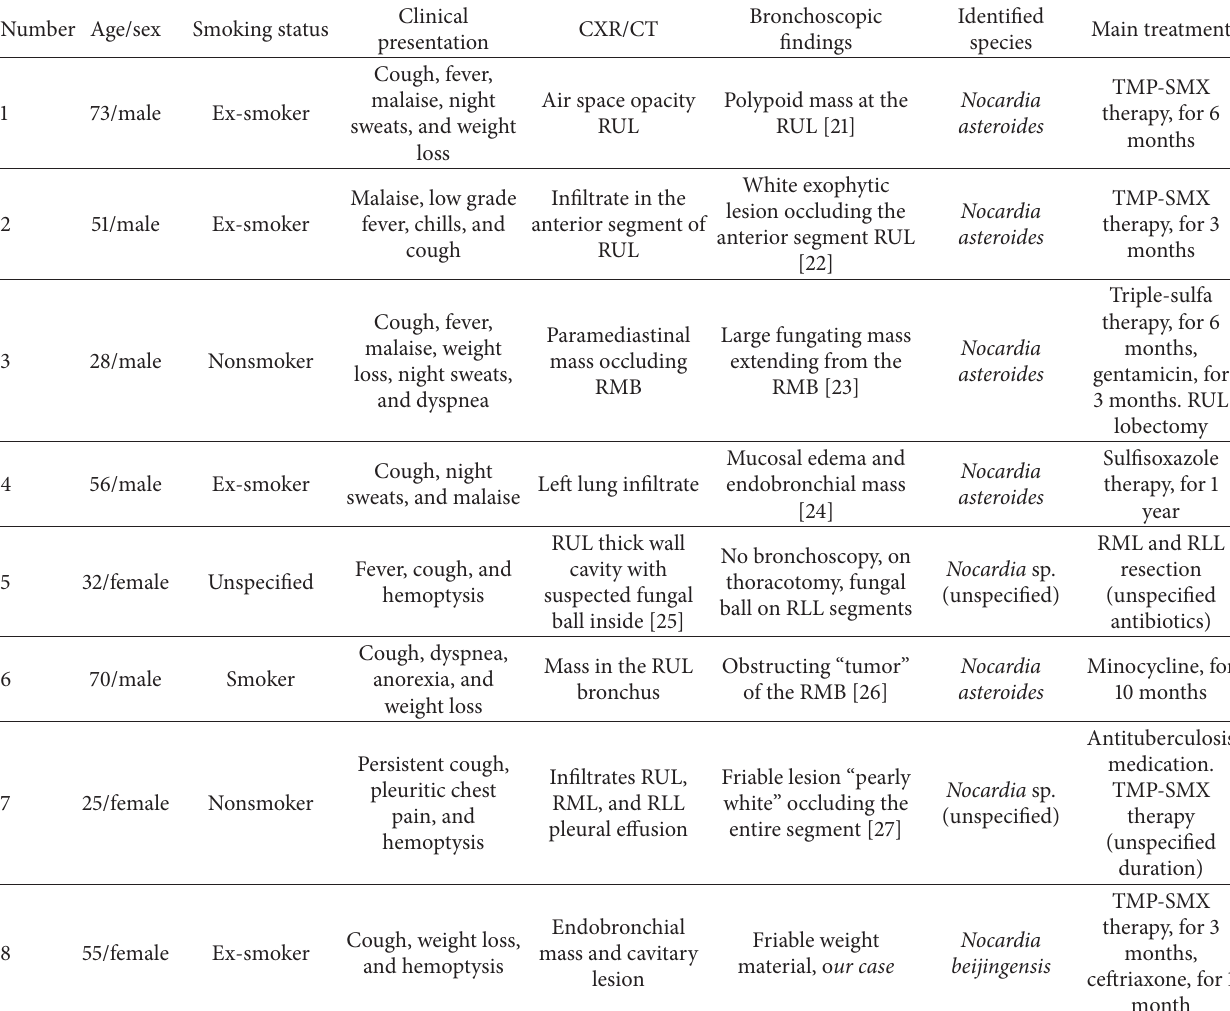
Table 2: Summary of pulmonary nocardiosis cases presented as endobronchial